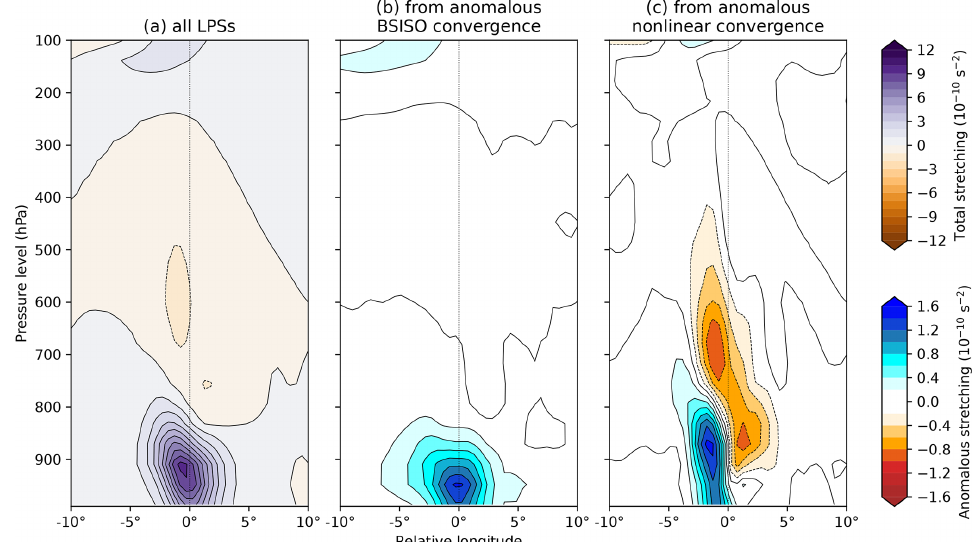
Figure 16. Zonal-vertical cross-sections of vortex stretching in monsoon LPSs. The composite average for all LPSs is given in (a) . The remaining subplots show contributions to the anomalous stretching in LPSs during BSISO phase 5 from (b) convergence from the mean BSISO itself and (c) convergence provided by the non-linear interaction between LPSs and the BSISO. Computed for monsoon LPSs north of 15 ◦